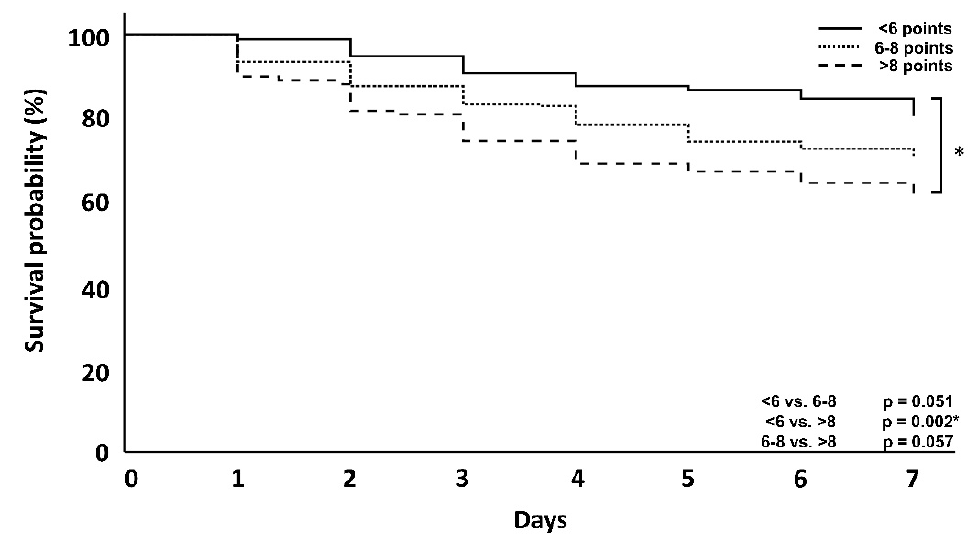
Figure 2. Kaplan–Meyer survival analysis at day 56 of the entire patient cohort. The p -values are via log-rank tests. * = Statistically significant using Bonferroni-adjusted alpha critical value = 0.017 for groups <6 vs. >8, but no other comparisons.